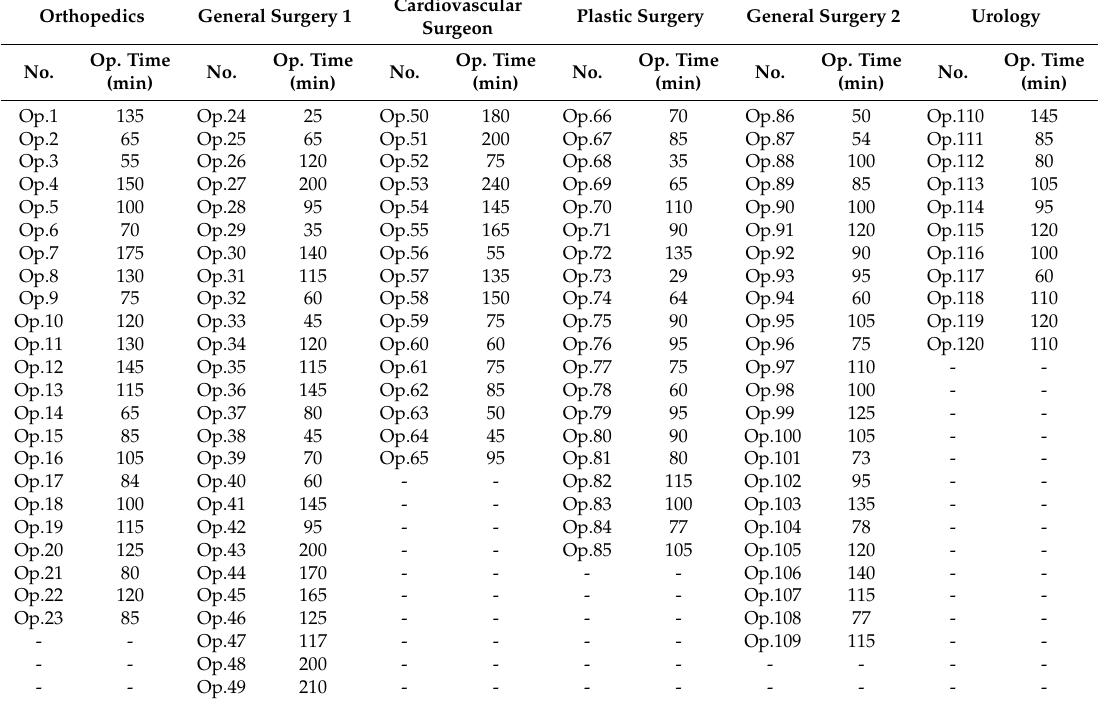
Table 1. Operating times (Op.: